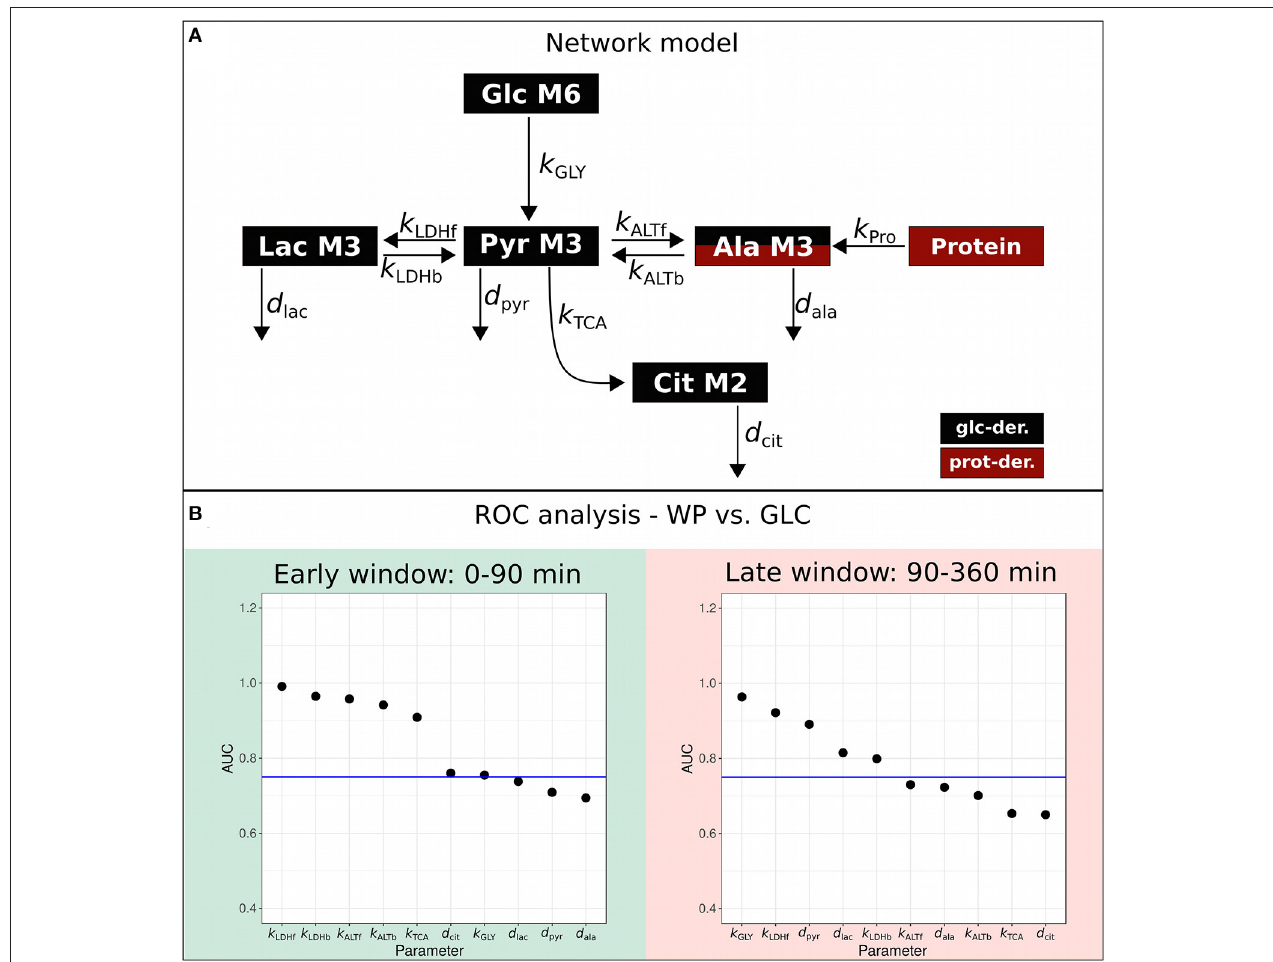
FIGURE 3 | Metabolic network model. (A) Metabolic network model. (B) ROC-AUC analysis to determine the most differentially regulated parameters, i.e., k -values between WP and GLC in the early (0–90min) and late (90–360min) postprandial phase; ROC-AUC above 0.75 is considered strongly regulated (blue horizontal